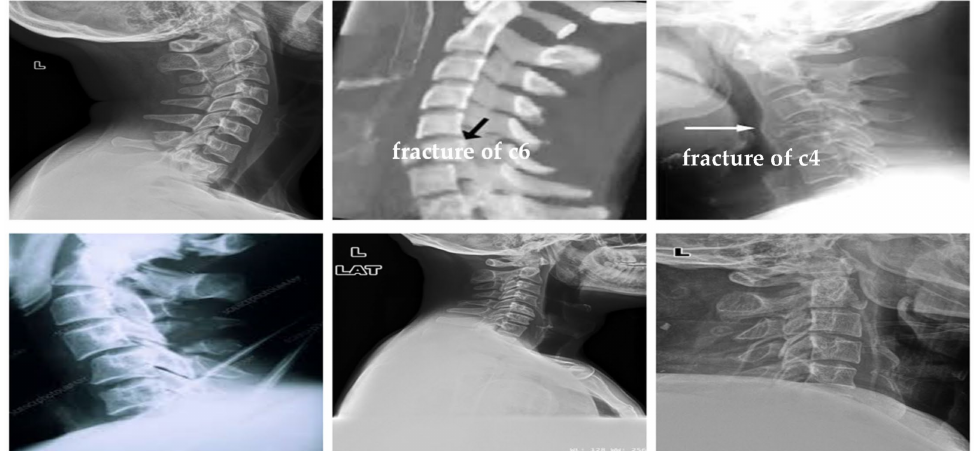
Figure 7. Samples from the second group (CS fracture images).